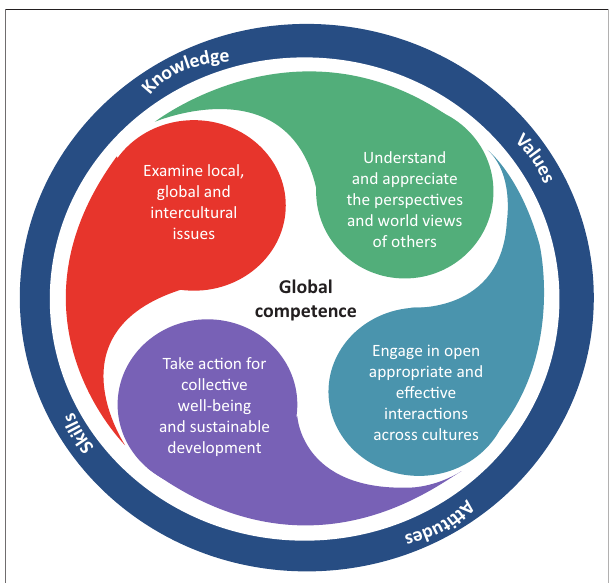
FIGURE 1: The dimensions of global